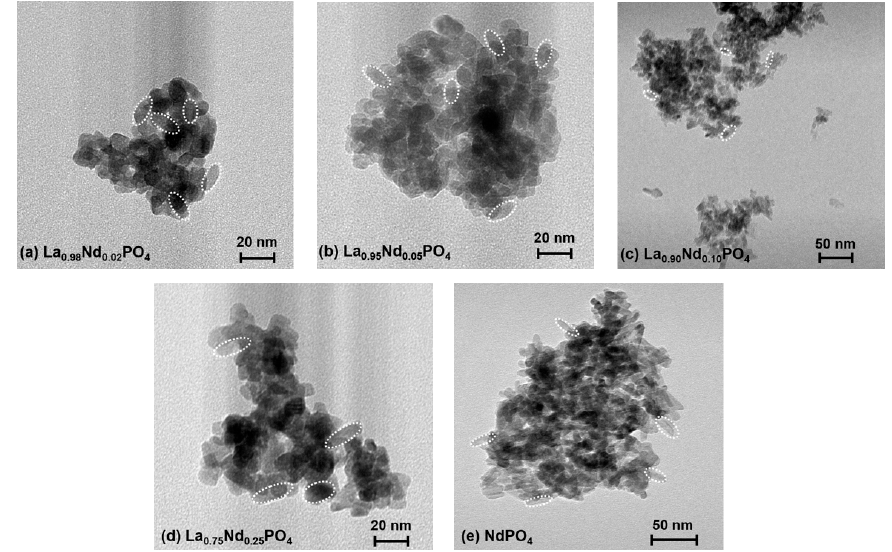
Figure 2. Transmission electron microscopy (TEM) images of the synthesized La 1 − x Nd x PO 4 nanocrystals: ( a ) x = 0.02, ( b ) x = 0.05, ( c ) x = 0.10, ( d ) x = 0.25 and ( e ) x = 1.00. Scale bars indicate either 20 nm or 50 nm, respectively. Selected single nanorods are marked by white dashed ellipses.